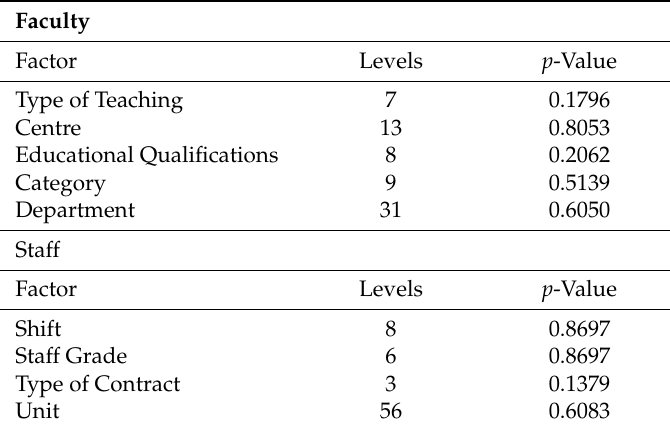
Table 5. Kruskal–Wallis analysis of Staff organizational factors. Table 6. Kruskal-Wallis analysis of faculty organizational factors.